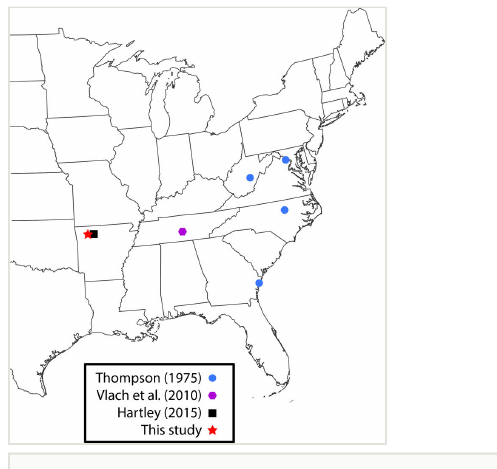
Figure 2. Lygistorrhina sanctaecatharinae collection localities.